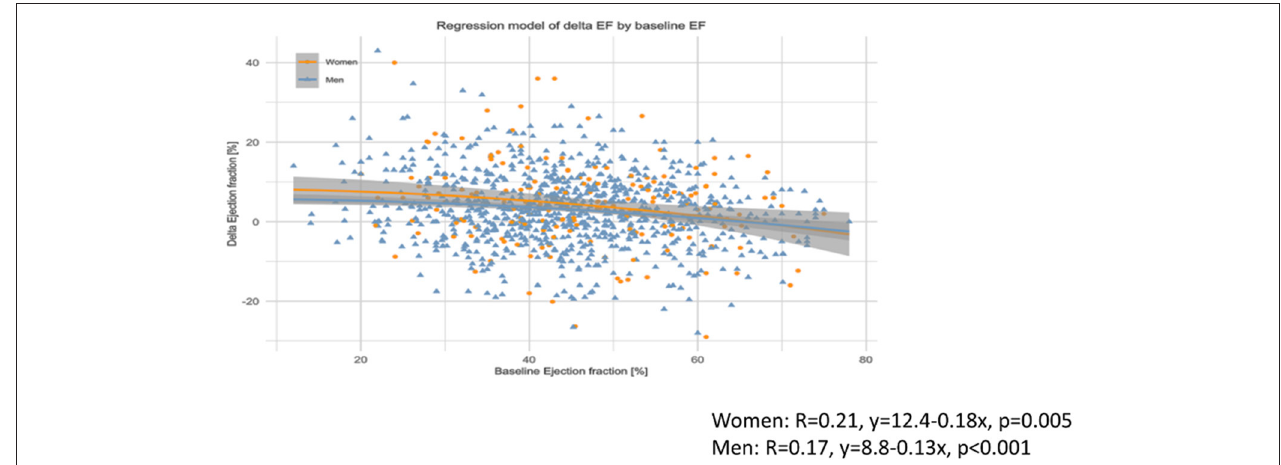
FIGURE 2 | Association between baseline ejection fraction (EF) and changes in EF in women and men. Significant but very weak negative correlation between baseline EF and changes in EF both in women and men, with no difference between the sexes.